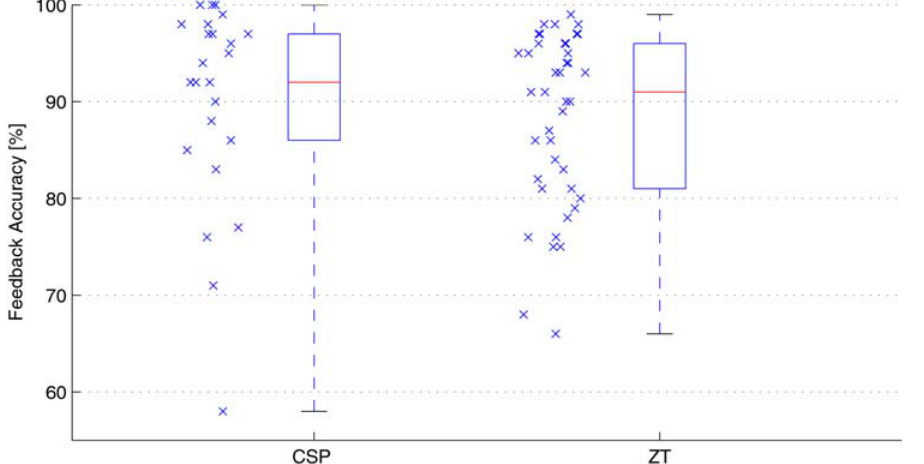
Figure 5. This figure shows the feedback performance of the CSP and the Zero-Training classifier over all subjects and runs. The median of the CSP feedback accuracy is slightly higher. This difference is not significant (Wilcoxon ranking test, p ,